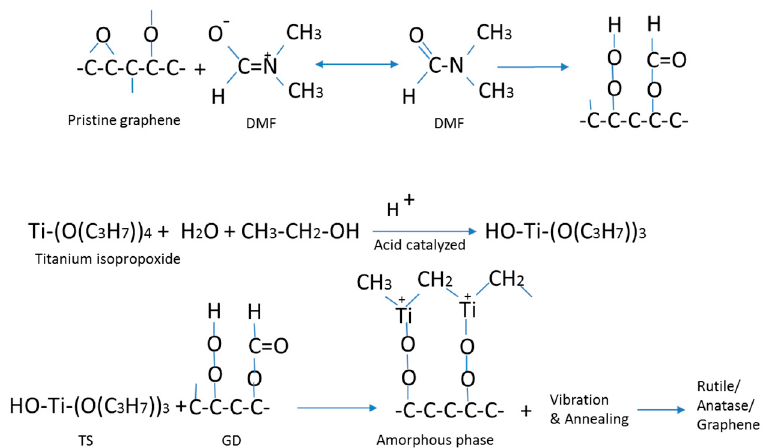
Figure 11. The top reaction shows the dispersion of graphene nanosheets in DMF. The middle reaction shows the coordination between TiO 2 precursors. The bottom reaction shows mixing of graphene and TiO 2 precursors and the sol ‐ gel process assisted by ultrasonic vibration.